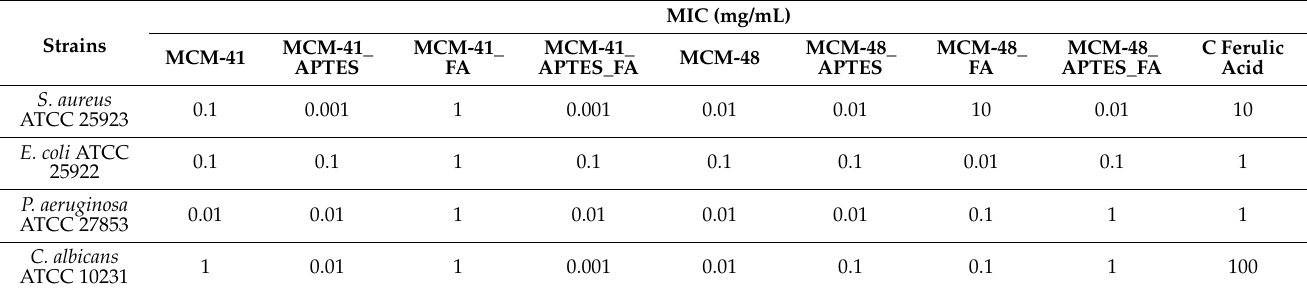
Table 5. Determined values for minimum inhibitory concentration (MIC).